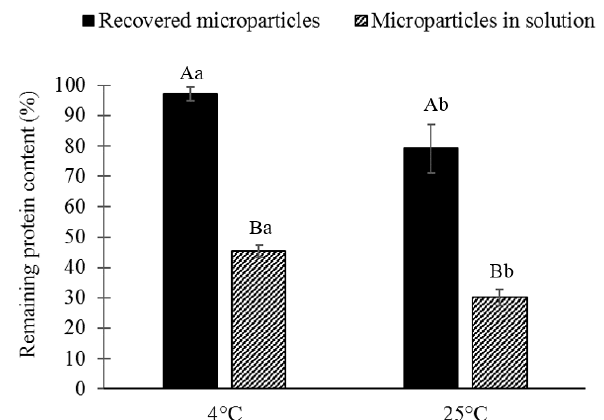
Figure 5. The remaining protein content after 30 days of storage. Microparticles were stored as recovered humid microparticles or in solution at 4 °C or 25 °C. Different lowercase letters indicate significant differences ( p ≤ 0.05) of the remaining protein content (%) among the different temperatures within the same type of sample. Different capital letters indicate significant differences ( p ≤ 0.05) of the remaining protein content among the different types of samples (recovered microparticles, microparticles in solution) at the same